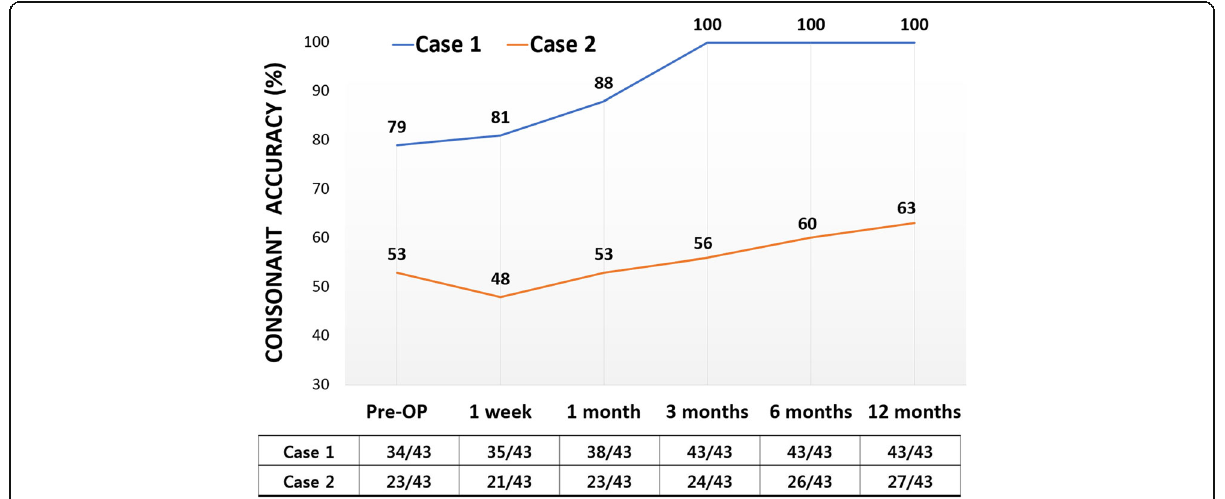
Fig. 4 Graph of development on consonant accuracy over time. The assessment was carried out for 43 consonant sounds, and the number of correctly produced consonants was counted to calculate the accuracy (%) as presented in the table below the